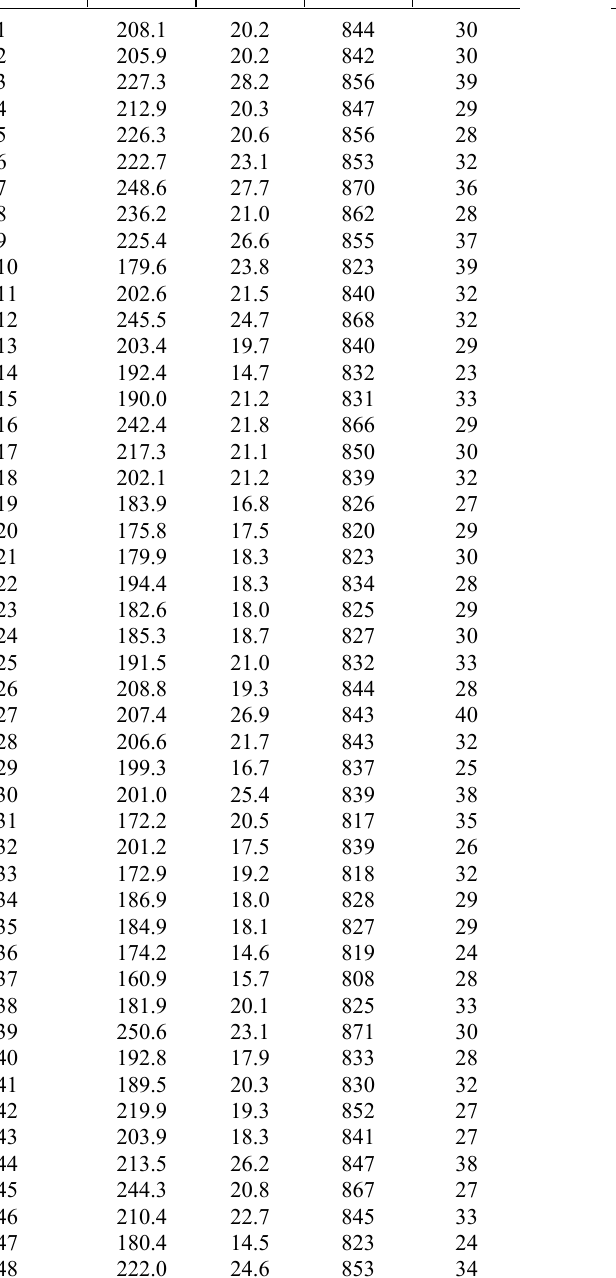
Table 2. Titanium content (measured with laser-ablation ICP-MS) and calculated crystallization temperatures of quartz phenocrysts (49 analyses) and groundmass (40 analyses) in the Suursaari quartz porphyry Analysis